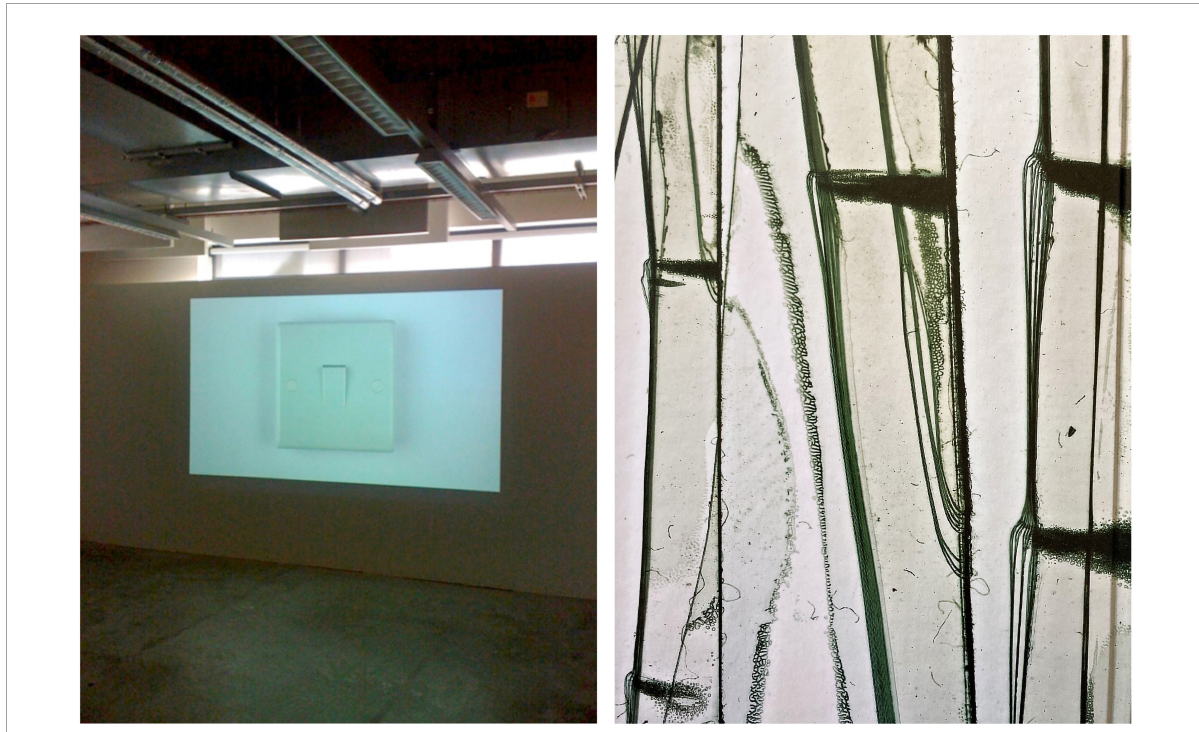
FIGURE4 Two exemplary artworks that can be interpreted as revealing contrasting top-down and bottom-up perceptual modes. (Left) “Obsession, Compulsion, and the Switch,” installation (2010), discussed in a Ph.D thesis titled “An Artistic Equivalence of my Obsessive Compulsive Disorder” (Baugh, 2015). A film of a light switch was projected onto a wall and played on a loop, alternating between bright light and darkness, with the intention to replicate the experience of repeatedly turning the switch off and on. This artwork implements themes of control and repetition, and features the image of a symmetrical, prototypical, predictable, and almost flawless object (reproduced with kind permission from the artist). (Right) “Scotch Tape,” color photo, 20 × 30 cm (2004), by an artist affected by advanced PD. The artist has been “meticulously documenting changes within her immediate urban and rural environment,” she “collects and classifies, assembles and arranges, prepares and analyses [ ... ] the unseen everyday world, [ ... ] to pay homage to the beauty of the banal.” Symmetry is of no relevance in her work, in which she reveals otherwise overlooked structure and variable patterns in the detail. Although these are selective examples, it is tempting to speculate that for an individual with OCD, similar levels of detail might be perceived as contamination. Reproduced with permission, © Brigitte Gauss, Zeitstrukturen, Kaleidoskop der unbesehenen Alltäglichkeit, Hrsg Edith Almhofer, DEA Buch- und Kunstverlag, Wien,